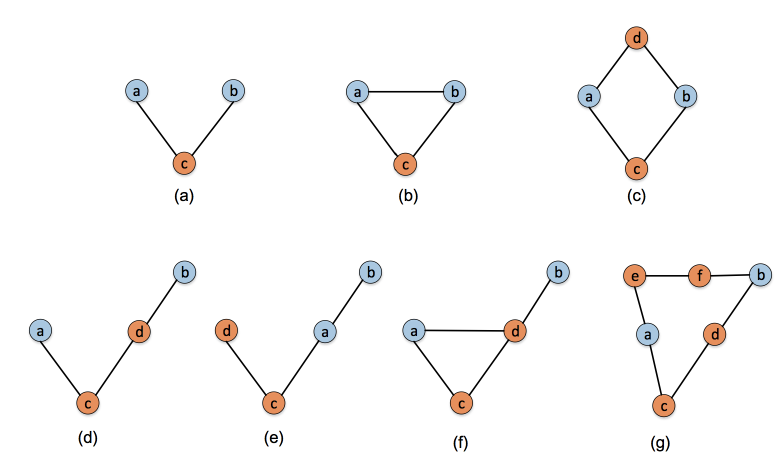
Figure 1. Several different connections between neighbor nodes a and b of node c . ( a ) node a and node b get connected by node c ; ( b ) nodes a , b , c get connected with each other; ( c ) node a and node b get connected by node c or node d ; ( d ) node a and node b get connected by node c and node d ; ( e ) node a and node b get connected directly; ( f ) node a and node b get connected by node d ; ( g ) node a and node b get connected by nodes c , d or nodes e , f